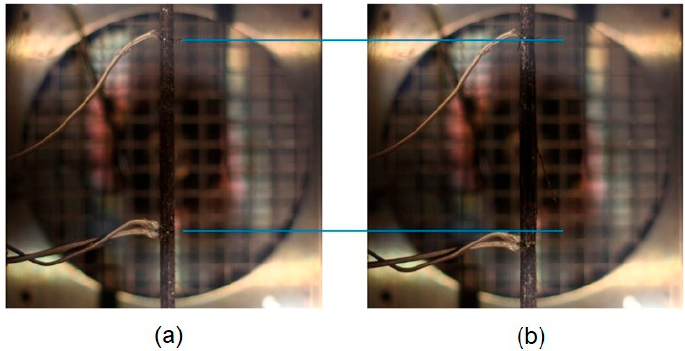
Figure 7. Thermogravimetric (TGA) plot (mass loss vs. temperature) for the UHM CFRP material. Figure 8. CFRP specimen prestressed at 700 MPa (Specimen 50d) immediately before ( a ) and after failure ( b ).